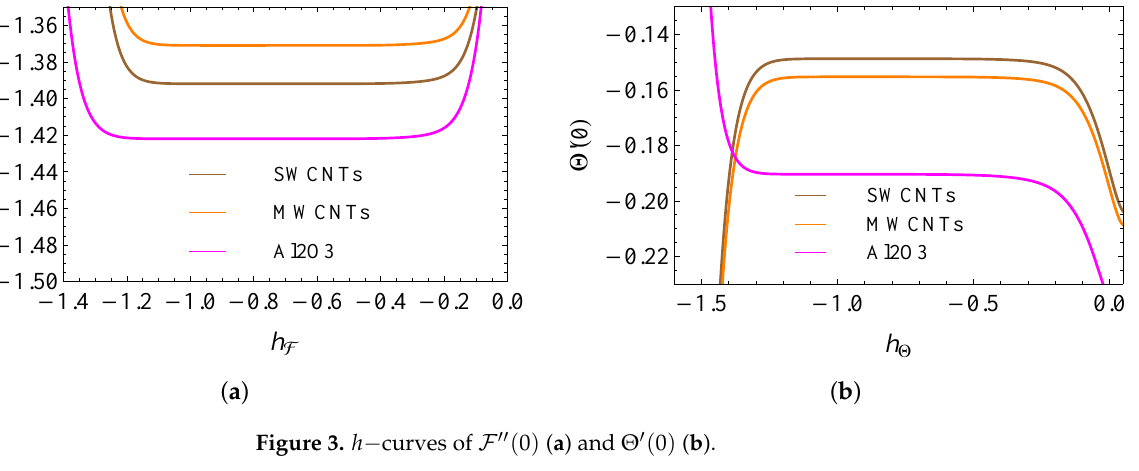
Figure 3. h − curves of F (cid:48)(cid:48) ( 0 ) ( a ) and Θ (cid:48) ( 0 ) ( b